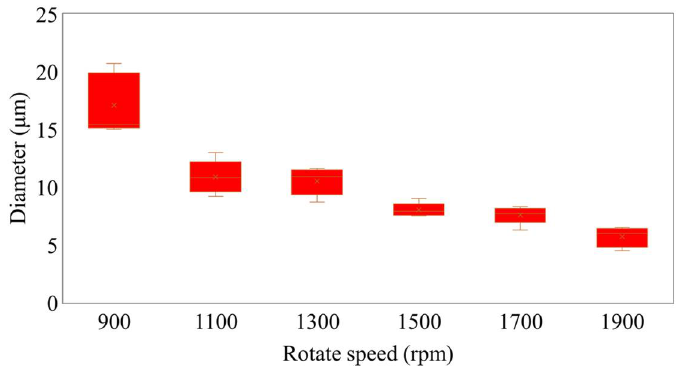
Figure 3. Relationship between the rotation speed of the hollow cylinder and the diameter of PVDF fibers.